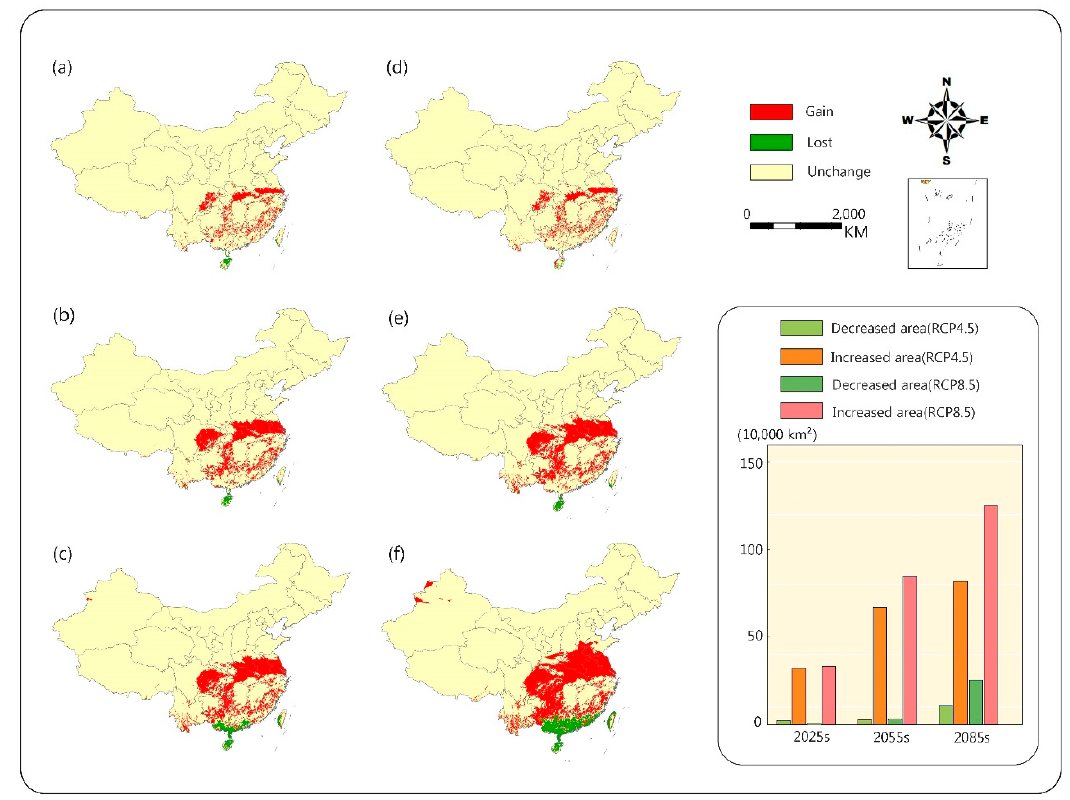
Figure 5. Change in habitat suitability of camphor tree in different periods in the future. RCP4.5: ( a ) 2025s, ( b ) 2055s, ( c ) 2085s; RCP8.5: ( d ) 2025s, ( e ) 2055s, ( f ) 2085s. The columnar graph shows the suitability changes in the area of different periods.